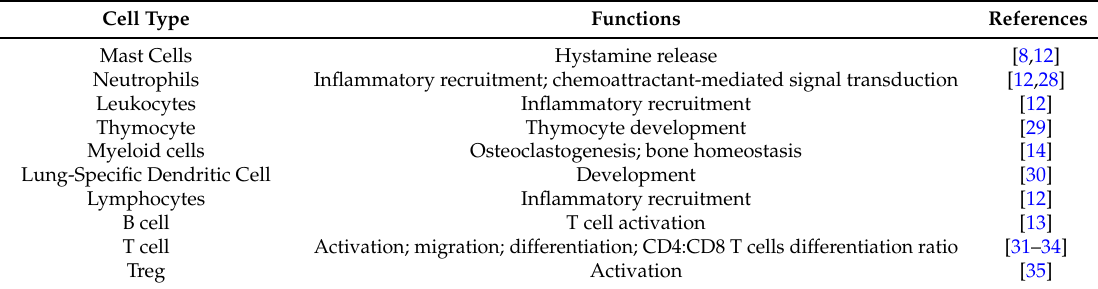
Table 2. PI3K γ functions in inflammatory responses